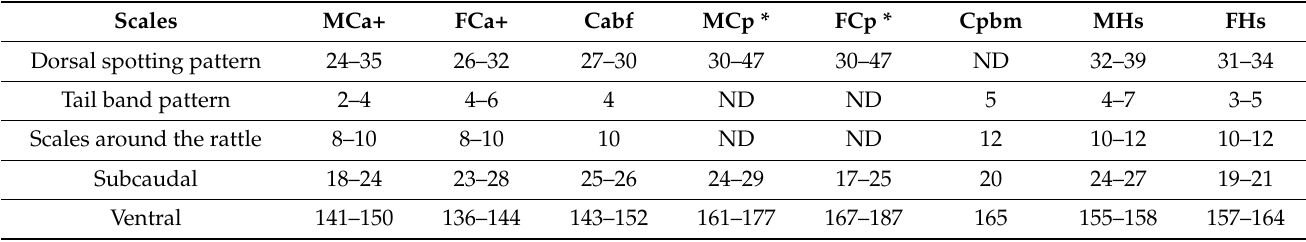
Table 1. Comparison between number of scales for C. aquilus , C. polystictus , Cabf, Cpbm, and the